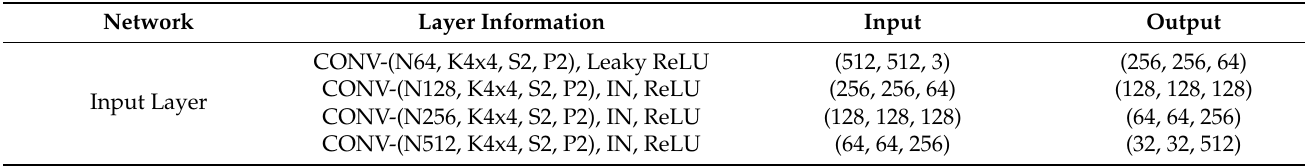
Table 2. The architecture of the